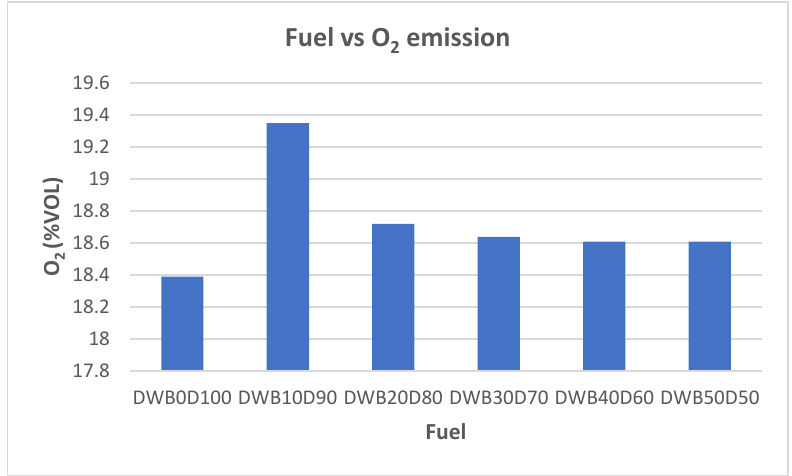
Figure 10. NO X emission from engine using diesel and diesel blended with distilled WCO biodiesel.